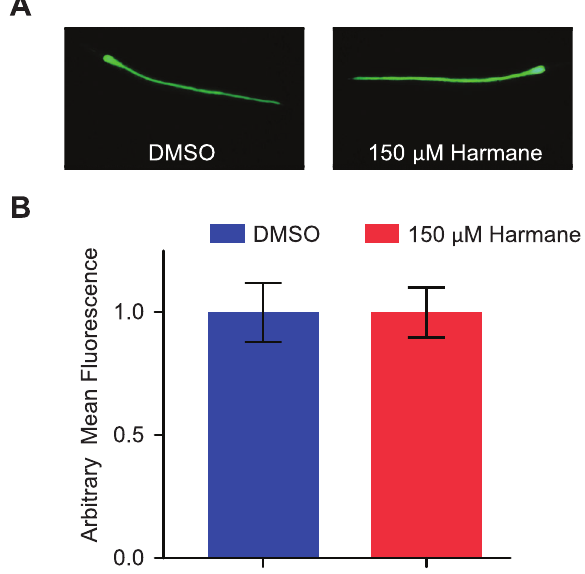
Figure 3. Harmane does not reduce the colonization-burden in C.elegans by E.coli EDL933. (A) Fluorescence microscopy pictures of sek-1 ; glp-4 mutant C. elegans after feeding 4 days on GFP-expressing E. coli EDL933, grown on either DMSO or Harmane. The pictures show examples of strongly colonized individuals. (B) Individual nematodes in fluorescence pictures were quantified, and data normalized to the level of the DMSO treated nematodes. There was no significant difference between the two samples [DMSO, n=56; 150 m M Harmane, n=69; error bars indicate SEM].